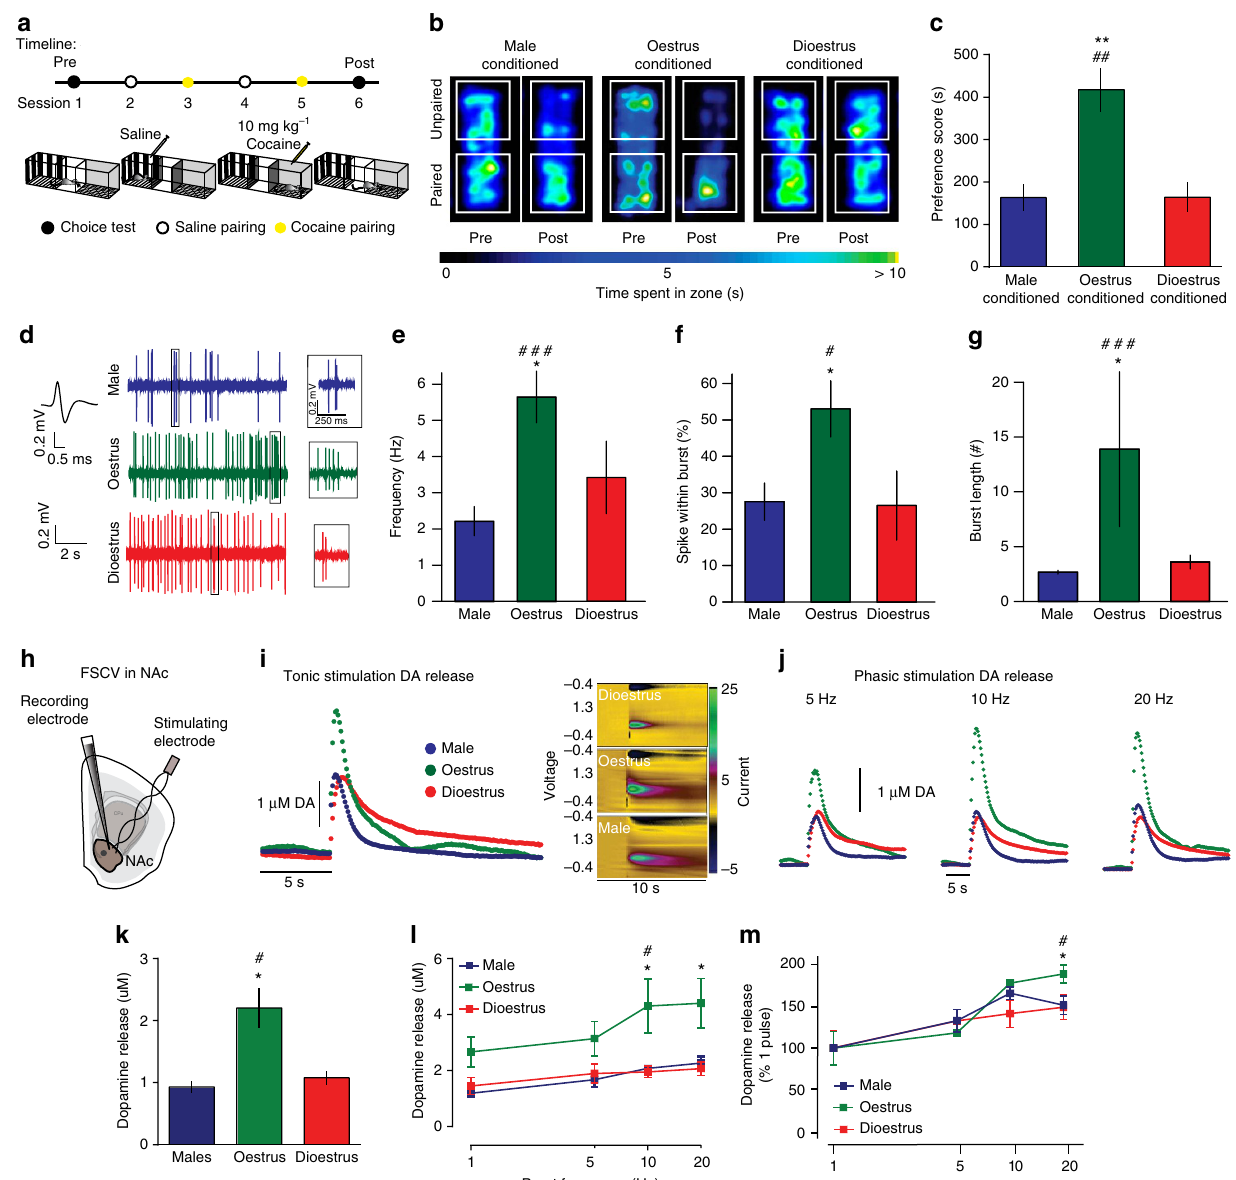
Figure 1 | Oestrus-conditioned female mice exhibit elevated CPP for cocaine and enhanced basal reward circuit function. ( a ) Timeline of cocaine CPP experiments. ( b ) Representative heat maps of time spent in each area of the CPP chamber for male (left), oestrus-conditioned females (centre) and dioestrus-conditioned females (right). ( c ) Increased CPP in females was only observed in mice paired with cocaine conditioning during oestrus (one-way analysis of variance (ANOVA); F (2, 12) ¼ 13.13, P o 0.001; **P o 0.01 oestrus versus dioestrus, ## P o 0.01 oestrus versus male). ( d ) Electrophysiological traces showing increased phasic activity of VTA dopamine neurons in oestrus females. In vivo single-unit electrophysiology of basal activity of putative VTA dopamine neurons identified increased: ( e ) firing rate (Kruskal–Wallis (KW) ( w 2 (2) ¼ 11.76, P o 0.005; * P o 0.05, ### P o 0.001), ( f ) percentage of spikes within burst (one-way ANOVA F (2, 36) ¼ 7.858, P o 0.005; * / # P o 0.05) and ( g ) burst length (KW ( w 2 (2) ¼ 10.17, P o 0.01; * P o 0.05, ### P o 0.001) in only oestrus females when compared with males (#) or dioestrus females (*). ( h ) FSCV recordings of subsecond dopamine release in the NAc. ( i ) Current versus time plots (left) and colour plots showing the presence of dopamine after one pulse tonic stimulation, as indicated by its oxidation at þ 0.6V and reduction at (cid:2) 0.2V. ( j ) Current versus time plots showing increased dopamine release to increasing frequency of five pulse stimulations. ( k ) Group data showing enhanced NAc dopamine per one pulse tonic stimulation in oestrus females (one-way ANOVA; F (2, 6) ¼ 11.57; * P o 0.05, # P o 0.05). ( l ) Phasic responsivity was increased in oestrus females (two-way ANOVA; F (6, 18) ¼ 3.279, P o 0.05; * P o 0.05, # P o 0.05). ( m ) Phasic responses represented as a percent of one pulse (tonic) release. Oestrus females exhibit increased dopamine release during phasic stimulations (two-way ANOVA; F (3, 14) ¼ 9.079, P o 0.05; * P o 0.05, # P o 0.05). *P o 0.05, **P o 0.01, ***P o 0.001 oestrus versus dioestrus (unless otherwise noted); # P o 0.05, ## P o 0.01 oestrus versus male. Data represented as mean ± s.e.m.